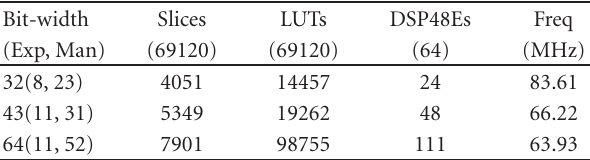
Table 5: Synthesis results. Virtex5